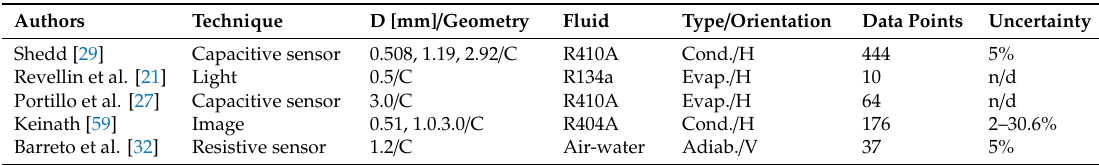
Table 3. Database for void fraction for